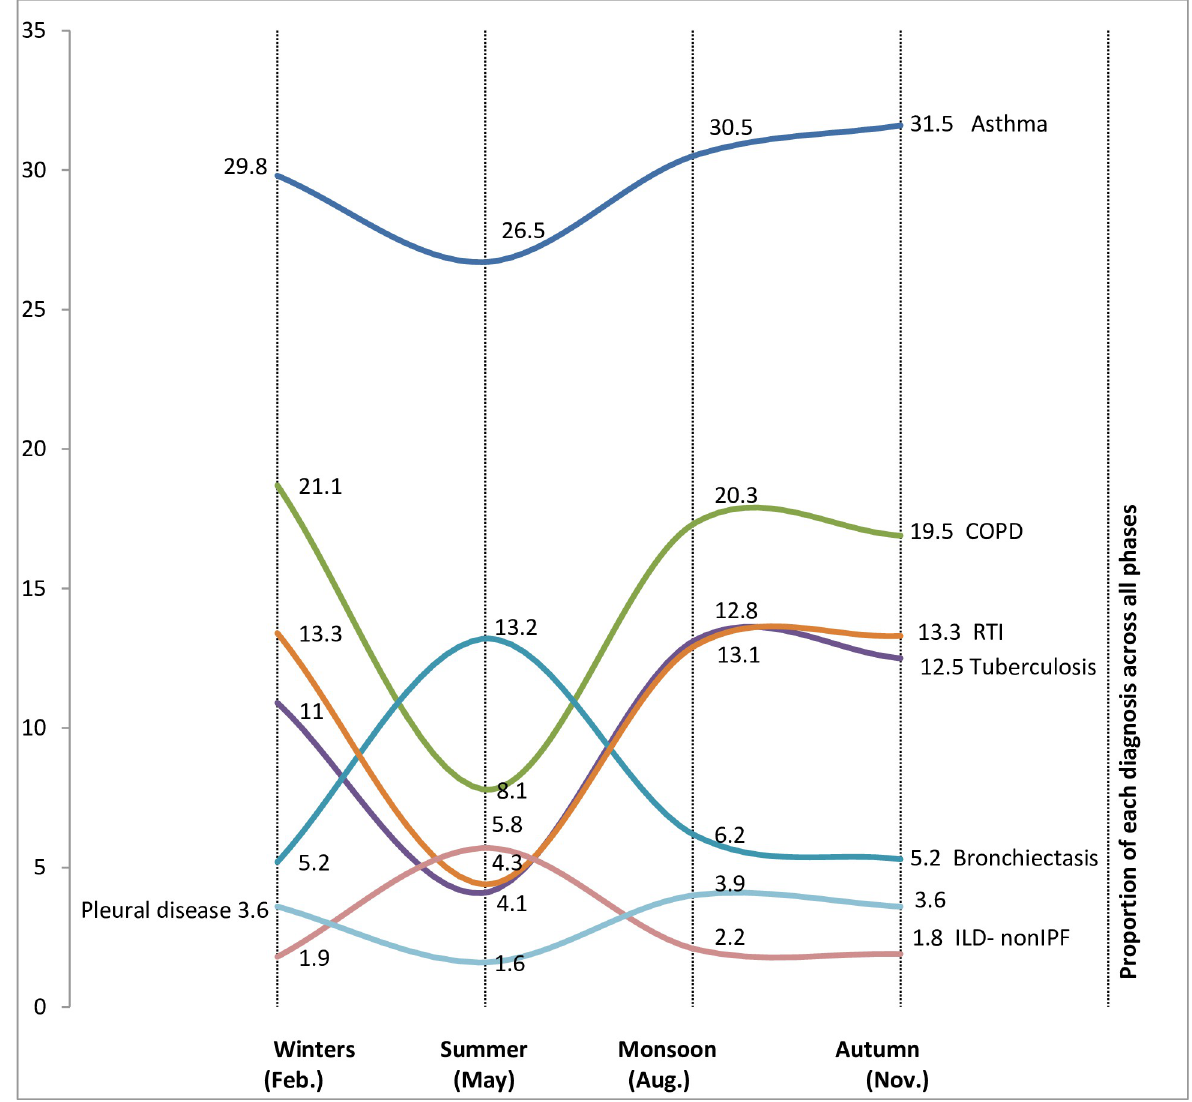
Fig 7. Seasonal patterns of major respiratory diseases in the SWORD study. Seasonal variations in the proportionate distribution of respiratory diseases at respiratory services across India. All major diseases including asthma, COPD, tuberculosis, RTIs, and bronchiectasis showed significant seasonal fluctuations. (Abbreviations: COPD = chronic obstructive pulmonary disease, RTI = respiratory tract infections including pneumonia, ILD = interstitial Lung Disease, IPF = idiopathic pulmonary